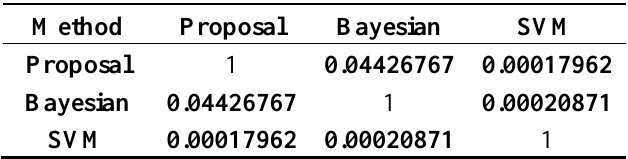
Table 4. Mann-Whitney test.